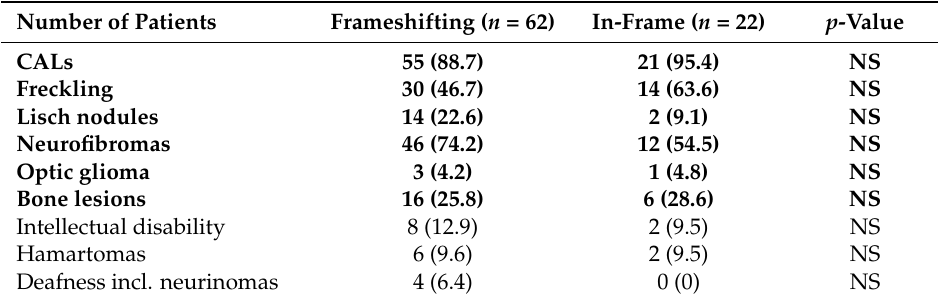
Table 5. Genotype–phenotype